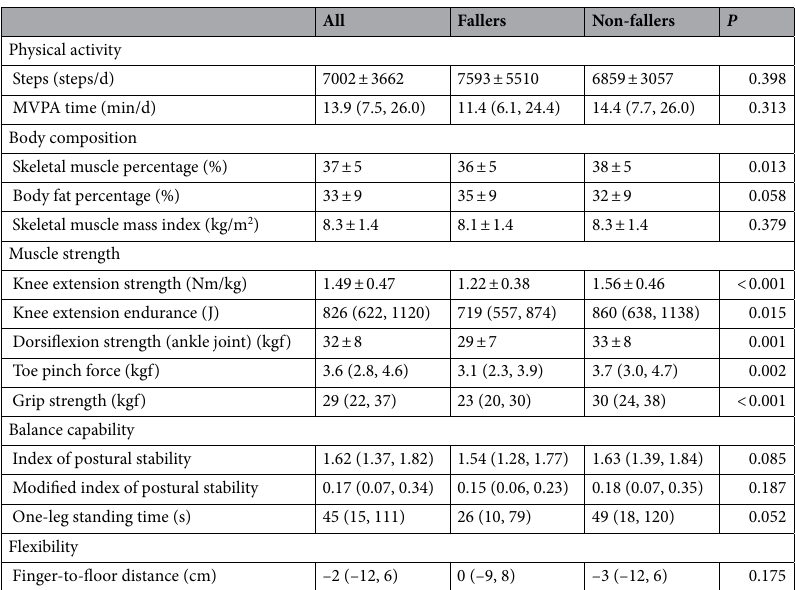
Table 3. Physical activity, body composition and physical capabilities of participants. Data are the mean ± SD or median (25th, 75th). MVPA, moderate-to-vigorous physical activity.